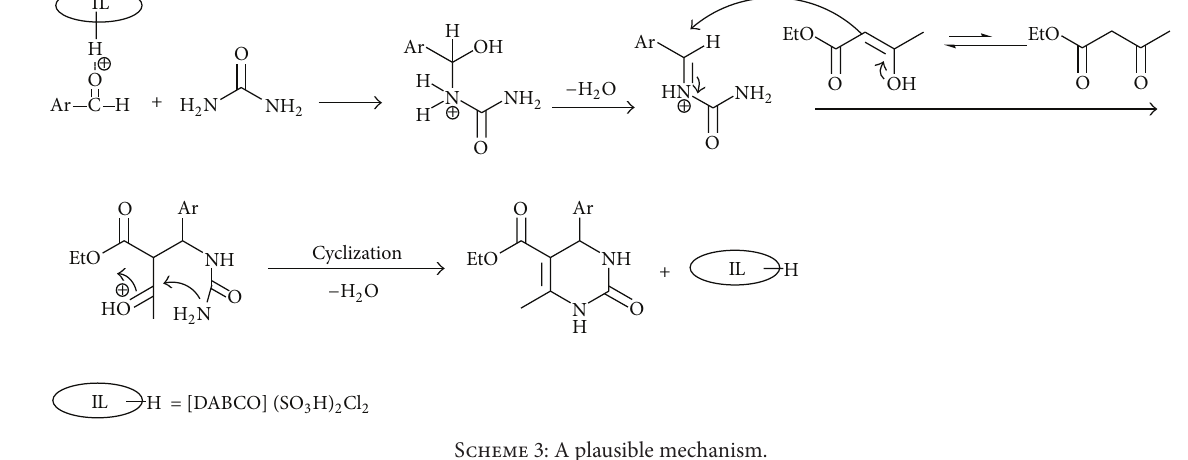
H) Cl -catalyzed synthesis of dihydropyrimidinones derivatives in EtOH. 3 2 2